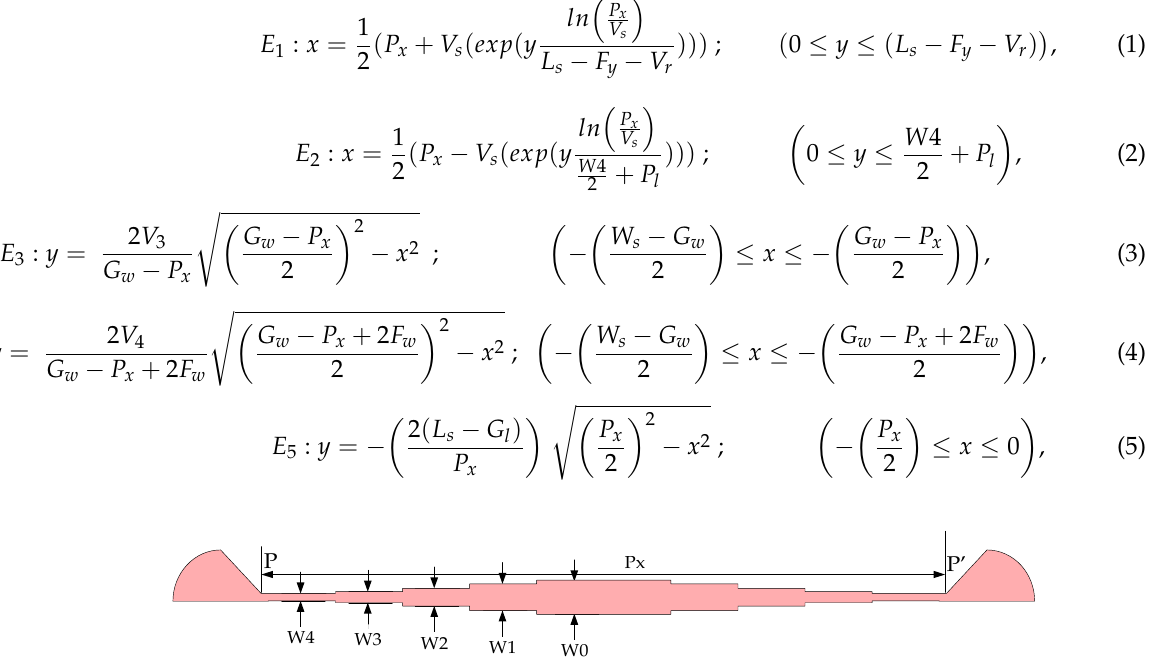
Figure 2. Structure of out-of-phase feeding microstrip line with Chebyshev multi-section 50 Ω to 100 Ω matching transformers designee using the following method [55]. The width of the calculated characteristics impedance of the three-section microstrip lines with reflection coefficient 0.05 for Taconic substrate of thickness 0.6 mm is W0 = 1.14 mm, W1 = 0.89 mm, W2 = 0.59 mm, W3 = 0.37 mm, and W4 = 0.25 mm. The length of each width of the section (W1 to W4) is a quarter of (Px/10) given that the total feeding length Px is 24 mm.